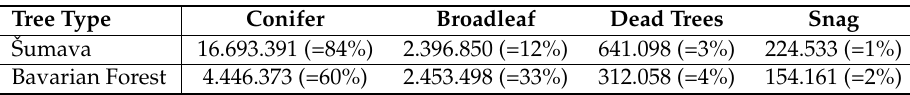
Table 18. Number of classified trees.